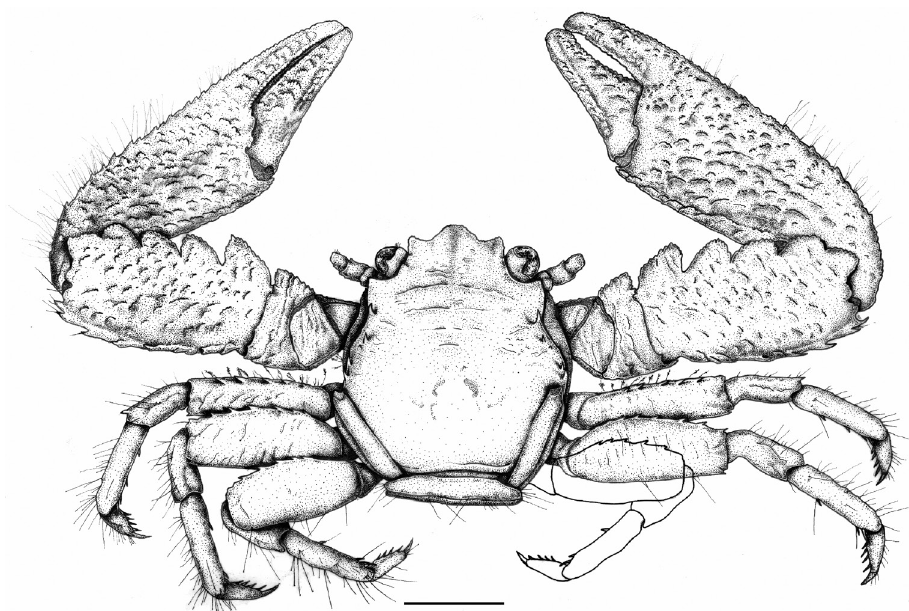
Figure 1. Petrolisthes paulayi sp. n. Male, holotype, dorsal view, UF43955, Line Islands, Palmyra Atoll. Right third walking leg supplemented. Scale bar: 2